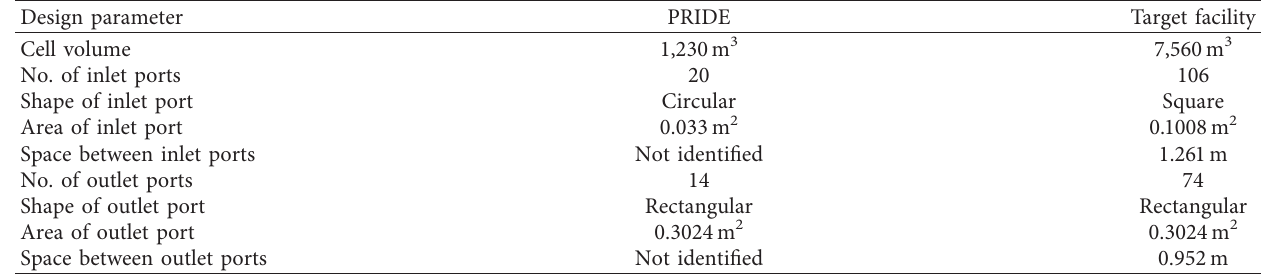
Table 2: Comparison of PRIDE and the target facility of this study (for regular operation).